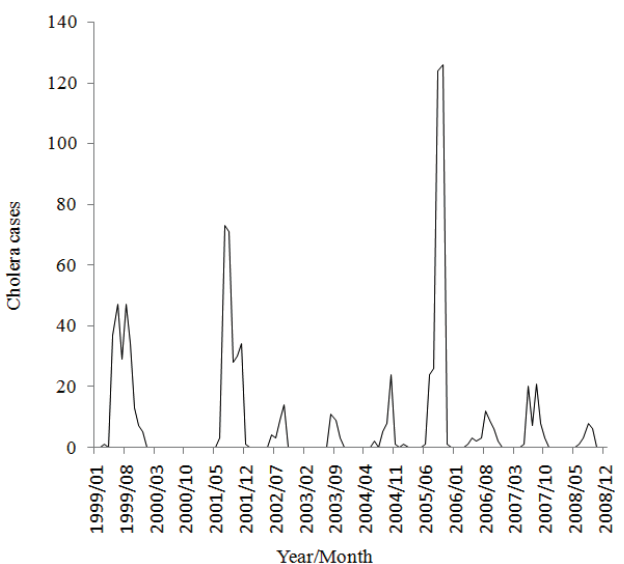
Figure3. Time seriesof monthly cholera cases in Zhejiang Province, China during 1999–2008.